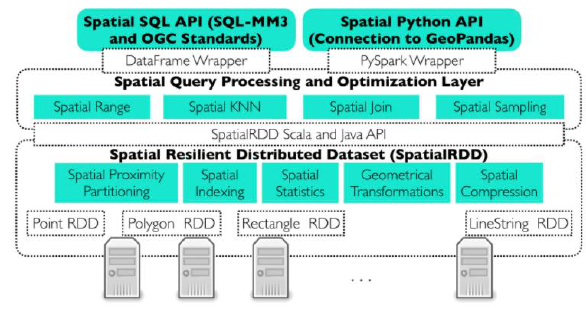
Figure 4 . Architecture of Apache Sedona